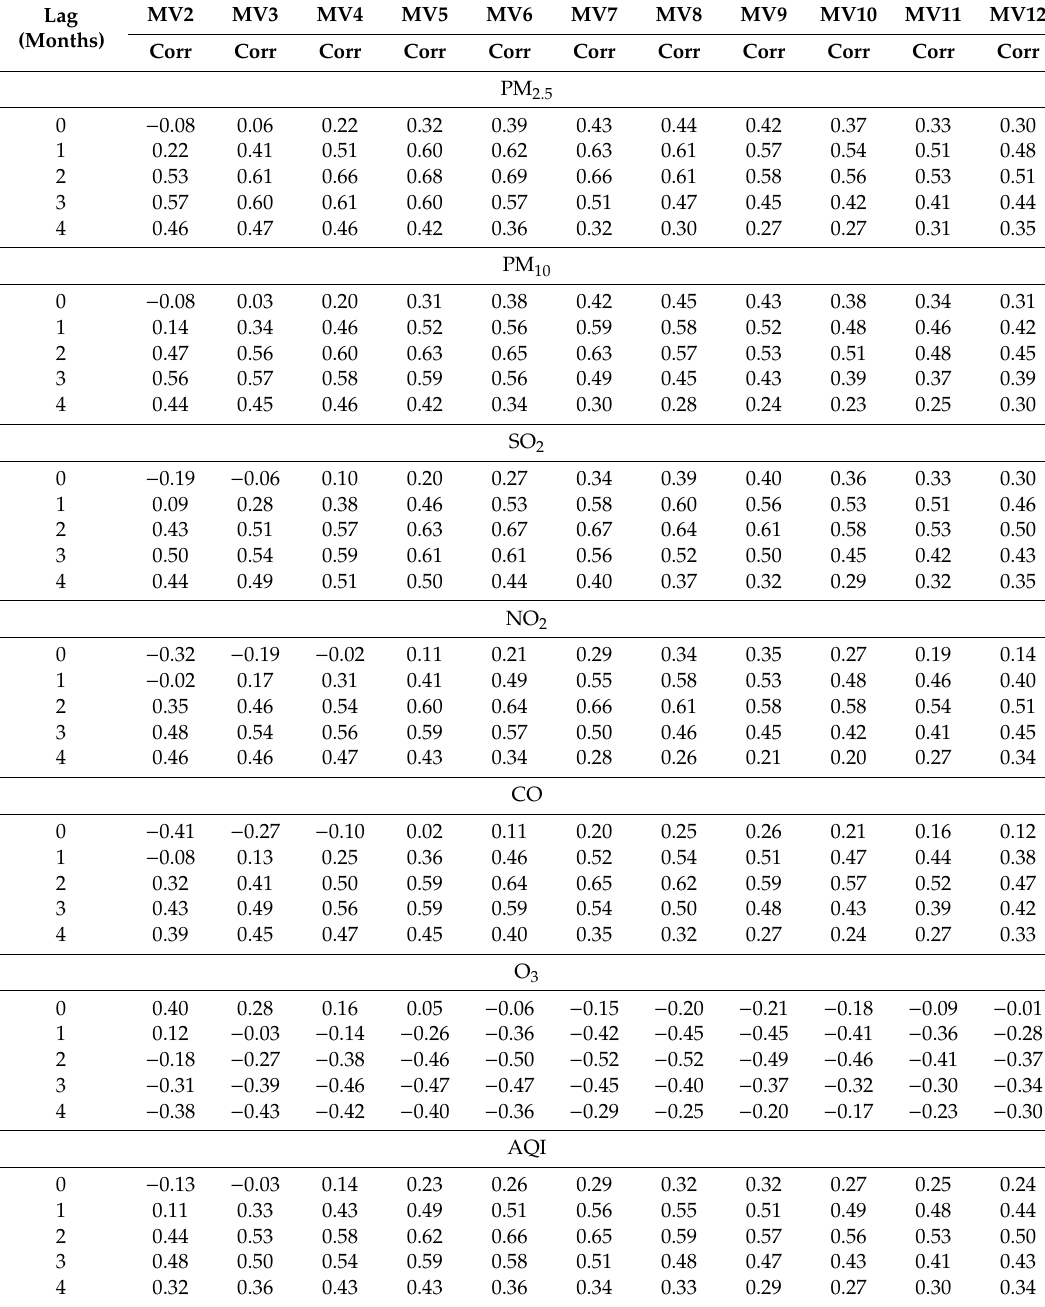
Table 2. Cross-correlation coe ffi cients between moving average (MV) concentrations ranging from 2 to 12 months of PM 2.5 , PM 10 , SO 2 , NO 2 , CO, O 3 , and AQI over a range of time lags (0–4) and the seasonality of